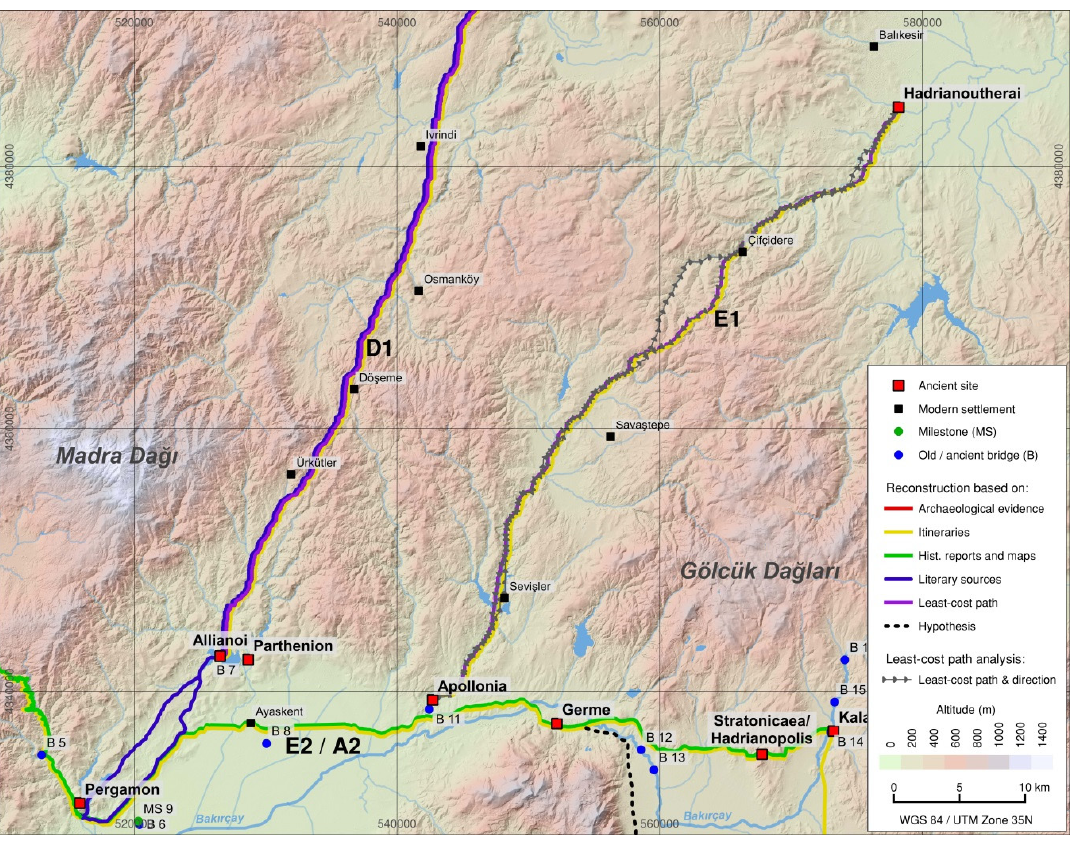
Figure 16. Calculated least-cost paths and reconstructed route between Hadrianoutherai and Apollonia.